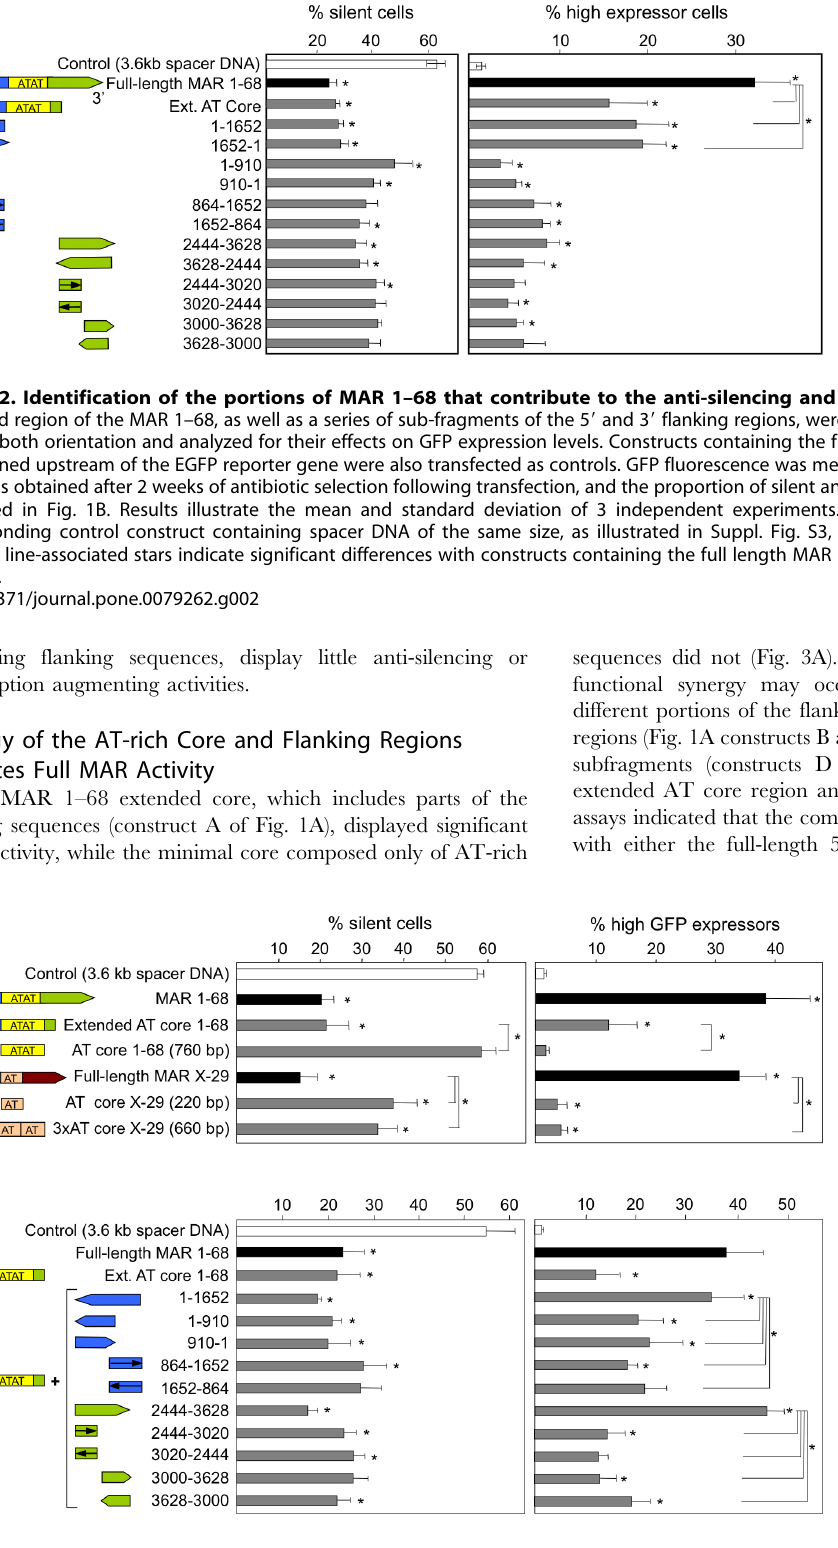
Figure 3. Relative contribution of MAR AT-rich cores and flanking sequences to the anti-silencing and transcriptional effects. The contribution of the AT rich DNA sequences of MAR 1–68 and X-29 alone (A), or combinations of the MAR 1–68 core with portions of its flanking sequences (B), were assessed for their anti-silencing and transcriptional augmentation activities as described in the legend to Fig. 2. An oligomeric form of the X-29 AT-rich region, consisting of three tandem repeats, was also analyzed. Results represent the mean 6 SD of 3 independent experiments and the statistical analysis are as for Fig. 2.